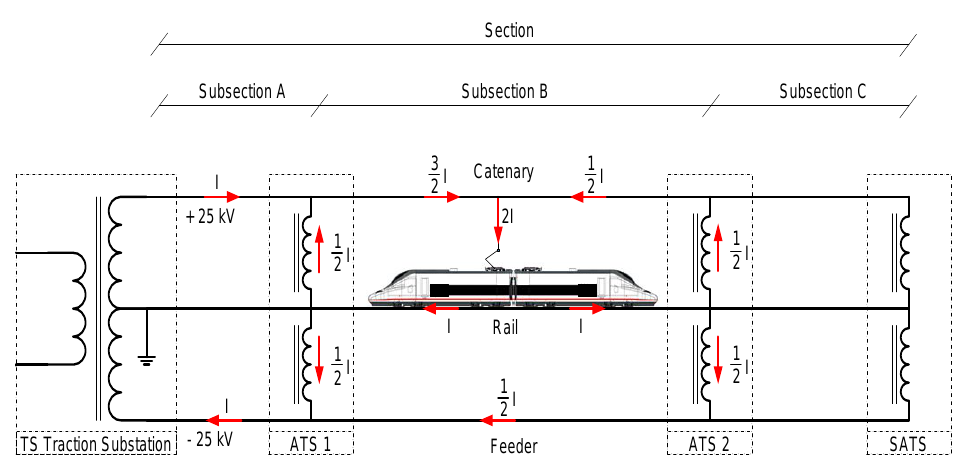
Figure 1. Simplified diagram of a 2 × 25 kV rail power system and current distribution while a train travels in subsection B.